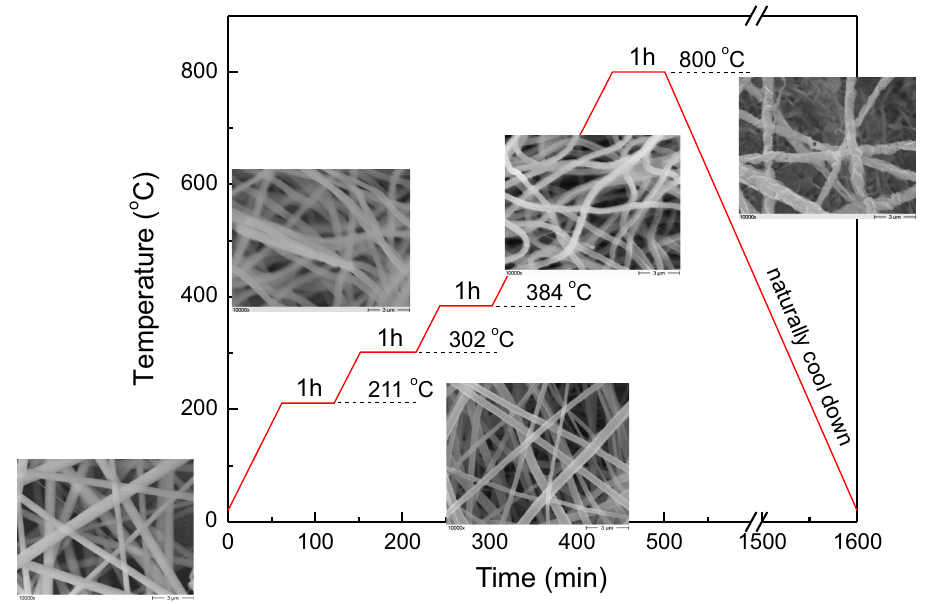
Figure 2. Heat treatment program of the Bi-2212 nanofiber mat samples. The inset SEM images (magnification 10,000 × , scale bar 3 µ m) show the development of the ceramic nanofibers at each temperature step which was determined by differential scanning calorimetry (DSC)/thermogravimetric analysis (TGA). The shrinking of the nanowires in the temperature treatment is clearly